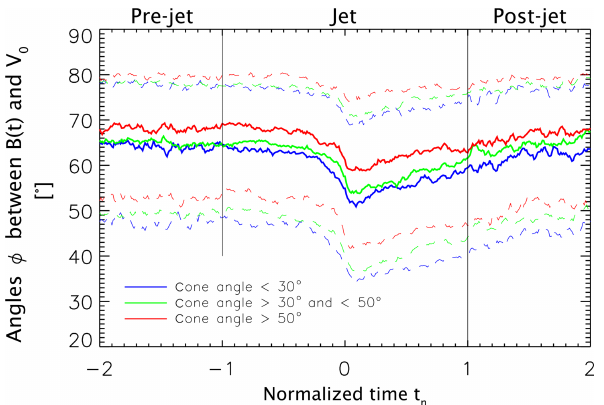
using Figure 5. Superposed epoch analyses of the angle φ B , V using only 0 0 jets featuring V 0 x > − 150kms − 1 in blue (1623 contributing jets), − 150kms − 1 >V − 200kms − 1 in green (3087 contributing 0 x > jets), − 200kms − 1 >V 0 x > − 250kms − 1 in red (2699 contribut- ing jets), and − 250kms − 1 >V 0 x in black (2348 contributing jets). As in Fig. 3, solid lines show median values and dashed lines show upper and lower